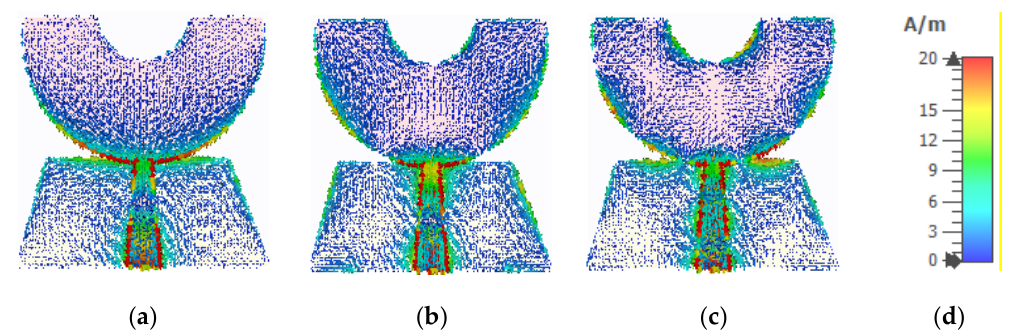
Figure 7. The surface current distribution at: ( a ) 3.50 GHz; ( b ) 5.50 GHz; ( c ) 10.00 GHz and ( d ) scale